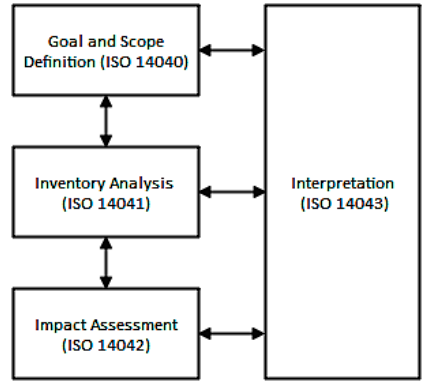
Figure 10. Conceptual framework of life cycle analysis (LCA) [153].